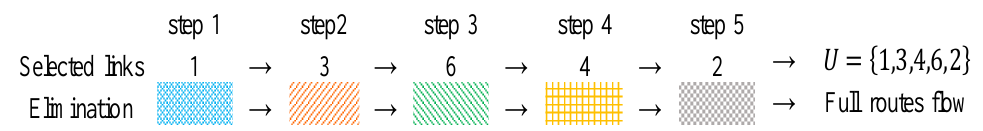
Figure 3. The procedure of selecting links and eliminating rows in greedy algorithm. Table 5. The process of greedy algorithm considering ‘differentiating first’ principle.